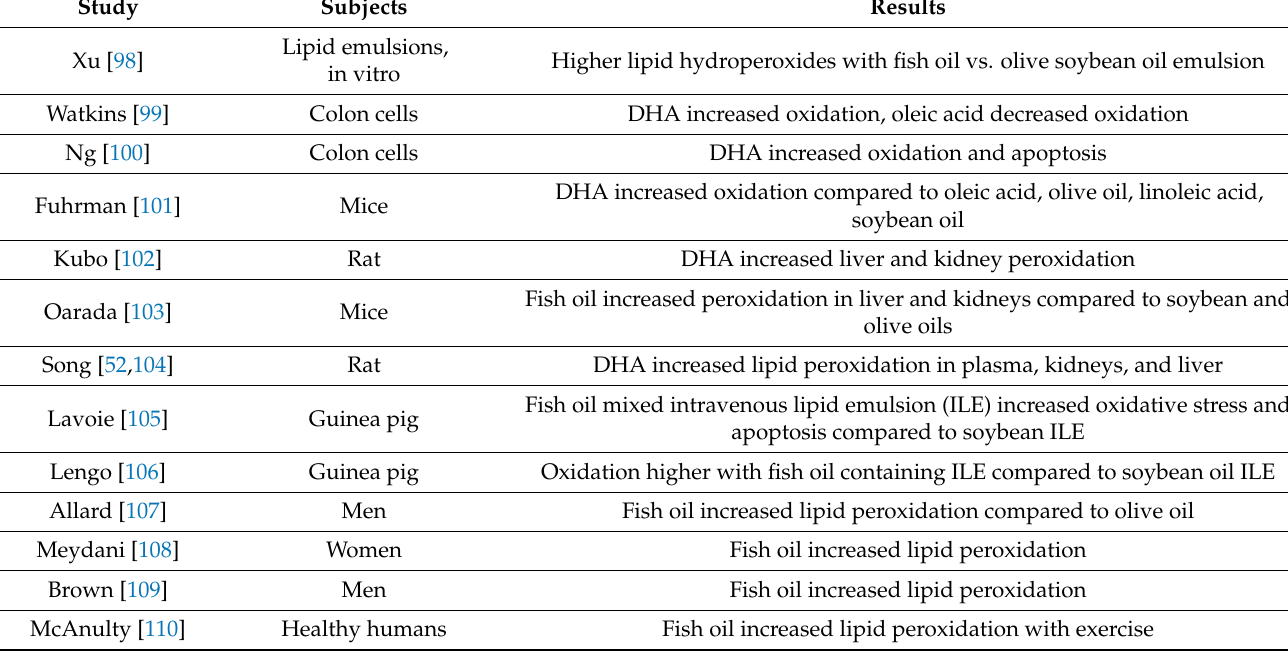
Table 4. Studies of n -3 PUFA and Lipid